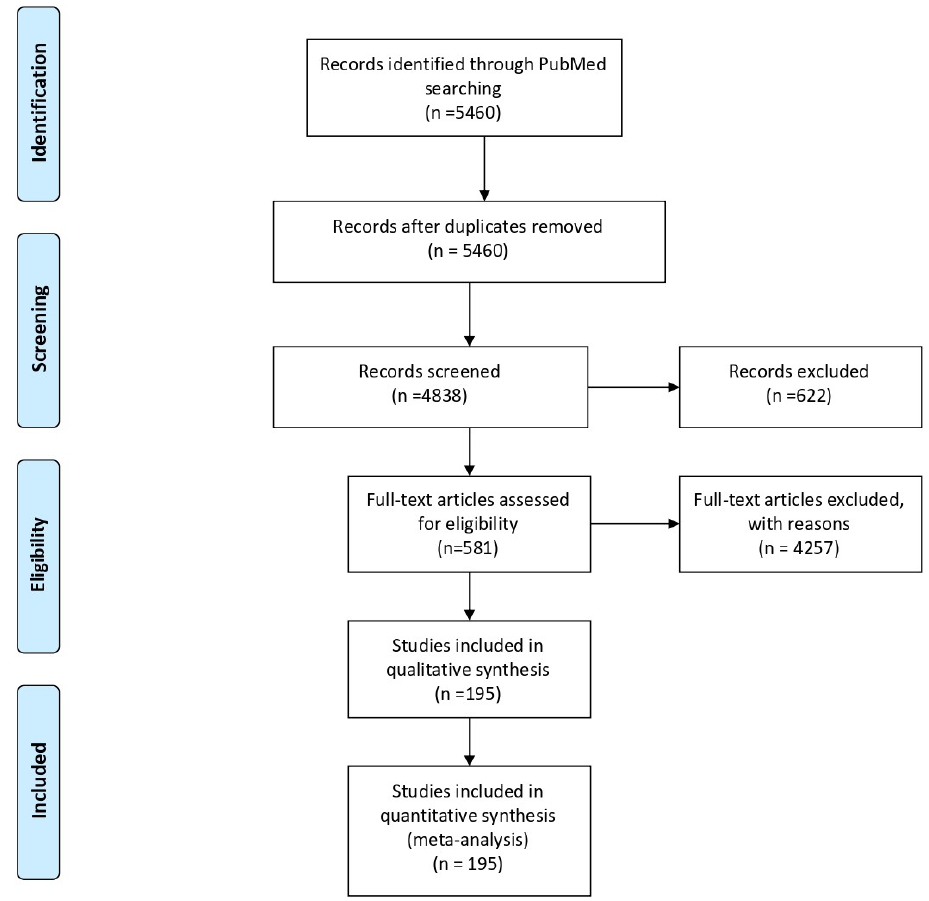
Figure 1. Flowchart of the identified, screened and included in this